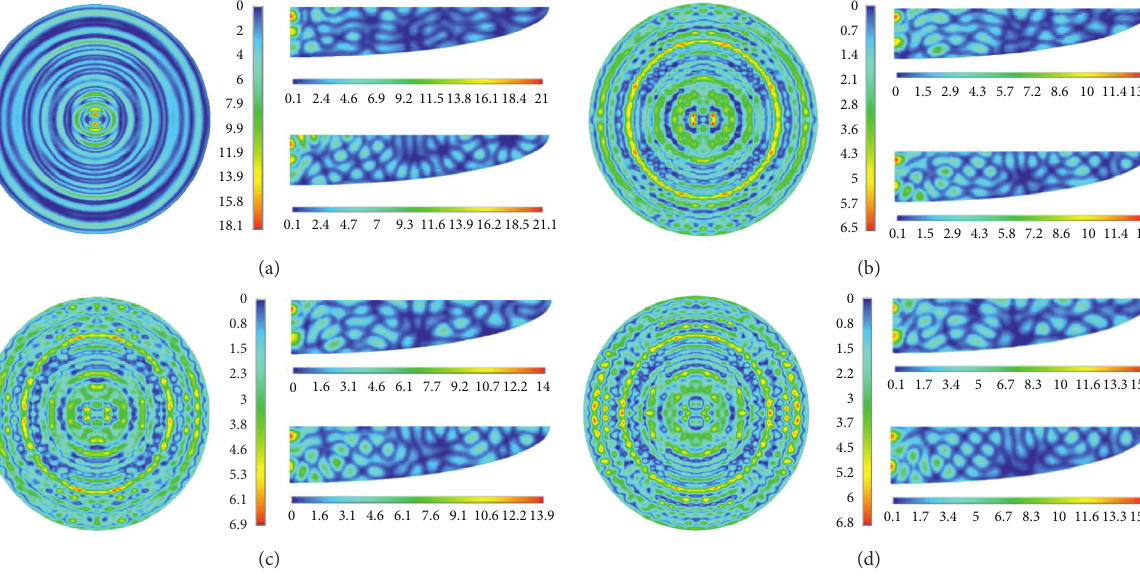
Figure 17: The displacement amplitude of the homogeneous sedimentary basin ( f � 5.0Hz): (a) no buildings; (b) D � 55m; (c) D � 62.5m; (d) D � 70